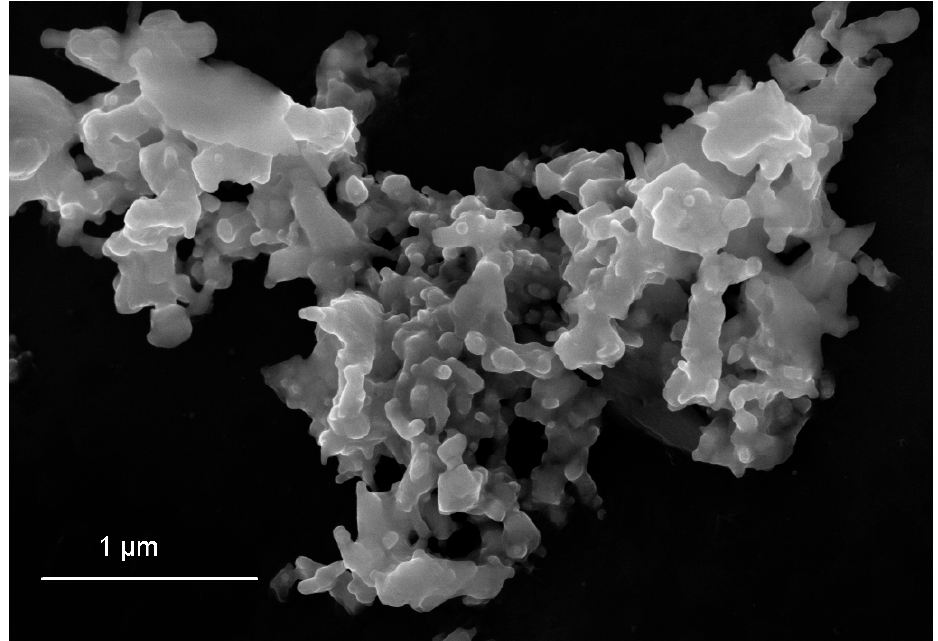
Figure 9. SEM micrograph of zinc oxide showing a large and complex agglomerate/aggregate.